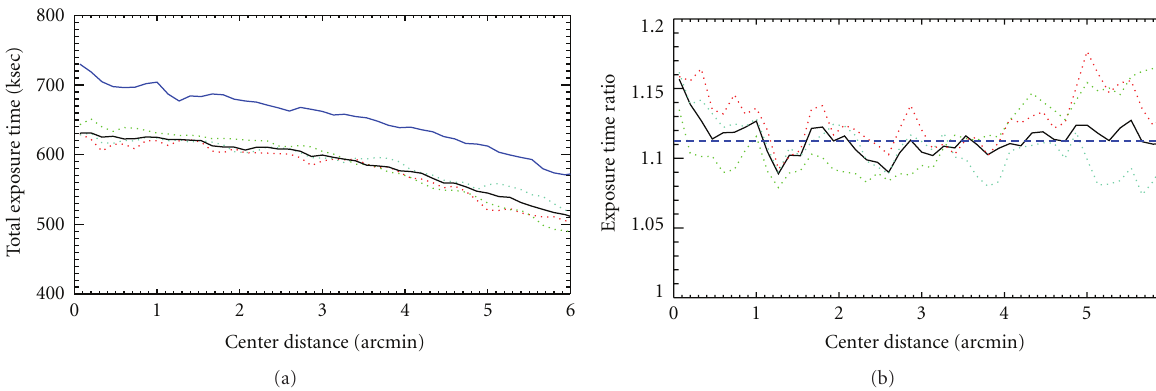
Figure 3: (a) Comparison of the stacked e ff ective exposure time radial profile with respect to the defined image center positions in the cluster fields (blue solid line), the average control field (black solid line), and the three individual control fields (dotted lines). (b) Fractional di ff erence of the stacked e ff ective exposure time profile of the cluster field and the average control fields as a function of radial distance from the field centers (black solid line). The blue dashed line indicates the median exposure time di ff erence of 11.3%, dotted lines depict the individual control fields as before.